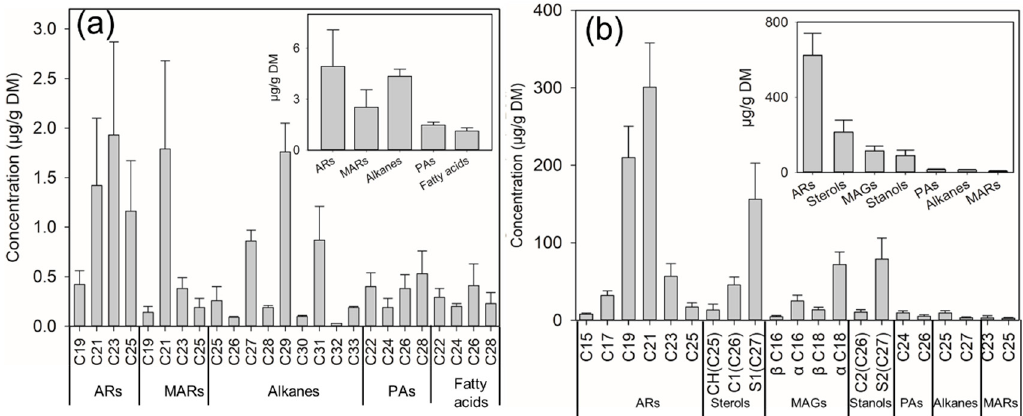
Figure 4. Composition and average content of SSL ( a ) and WGL ( b ) from 36 wheat samples. The ordinate shows carbon atom number. SD, standard deviation. The data are expressed as the mean ± SD (n = 36).